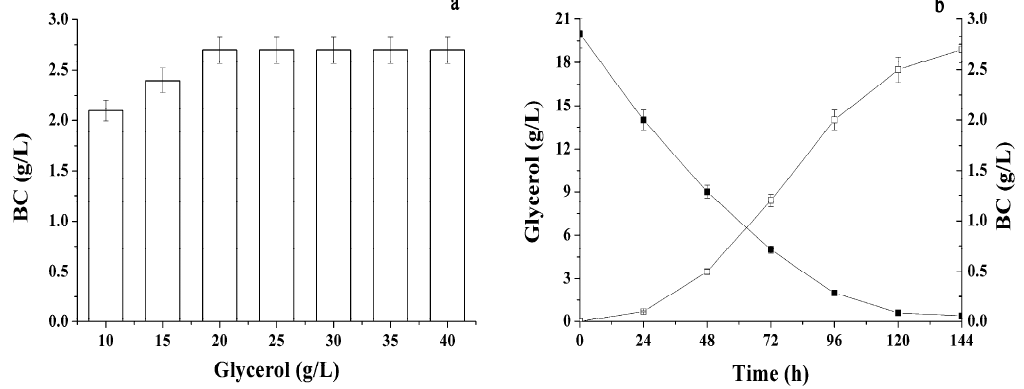
Figure 5. Influence of glycerol concentration in medium as a single carbon source on the synthesis of BC by immobilized Komagataeibacter xylinum cells ( a ) and the kinetics of glycerol consumption ( (cid:4) ) and BC production ( □ ) in a medium with 20 g/L glycerol ( b ).